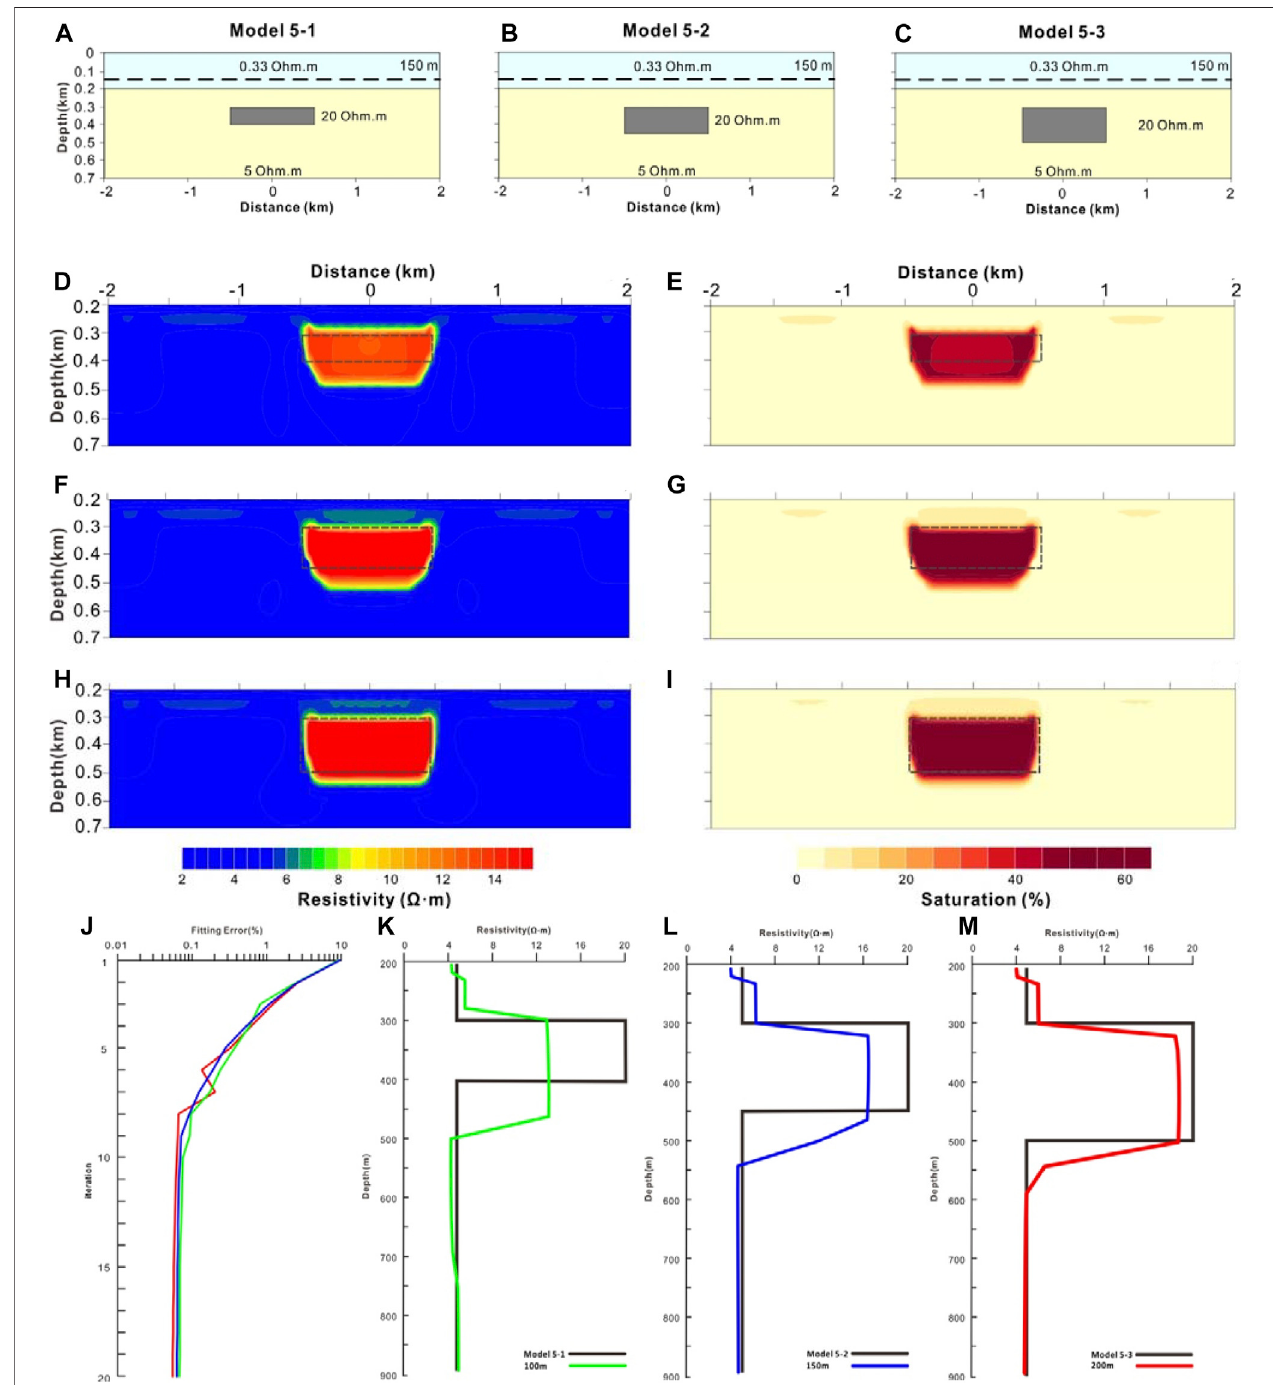
FIGURE 8 | Resistivity inversion and hydrate saturation estimation of various thickness models of hydrate reservoir. (A) – (C) : the schematic diagram of Model 5 – 1, 5 – 2,and5 – 3respectively,lightblueindicatesseawater,lightyellowindicatesmarinesediments,grayblockindicateshydratereservoirs,dottedlineindicatesthetrackof the towed DCR array arrangement; (D) , (F) and (H) : the inversion resistivity of Model 5 – 1, 3 – 2, and 5 – 3 respectively; (E) , (G) and (I) : the hydrate saturation estimation of Model 5 – 1, 5 – 2, and 5 – 3 respectively (J) d: the inversion iteration convergence of Model 5 – 1(green), 5 – 2(blue) and 5 – 3 (red), respectively (K) – (M) : the resistivity pro fi le with depth at the center x position of hydrate reservoir of Model 5 – 1(green), 5 – 2(blue) and 5 – 3 (red), respectively.